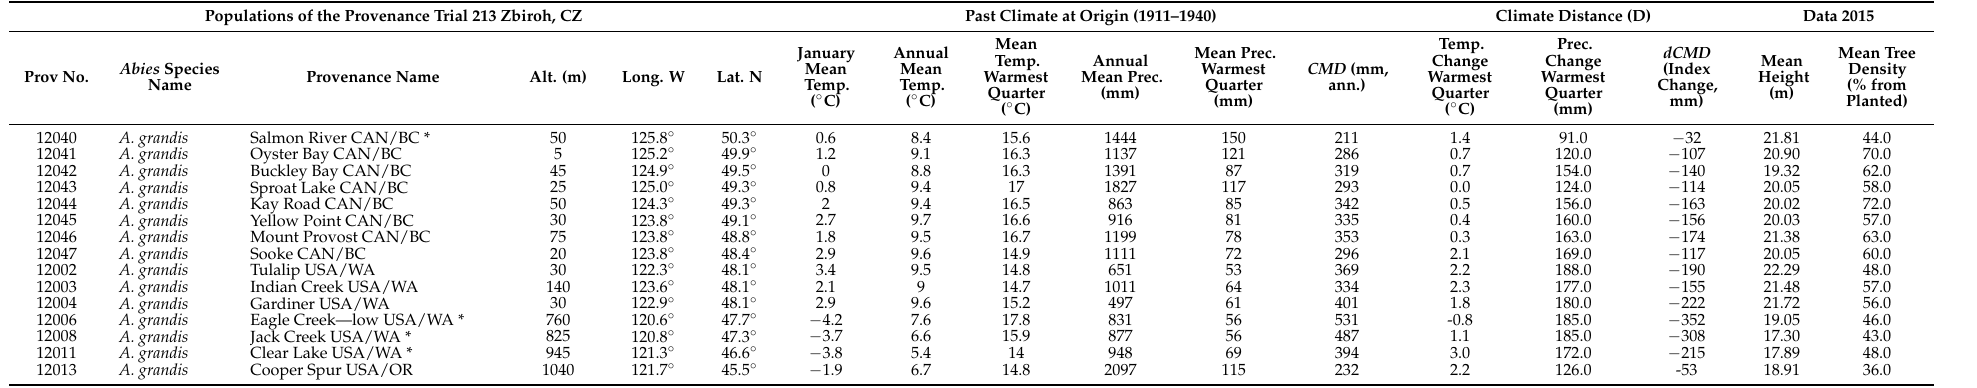
Table 4. Basic data of the provenance trial 213 Zbiroh: location and climate of grand fir populations used for analysis (sequence and geographic data of provenances are identical to the source publication (Adapted partly from [20]). Climate distances refer to the trial